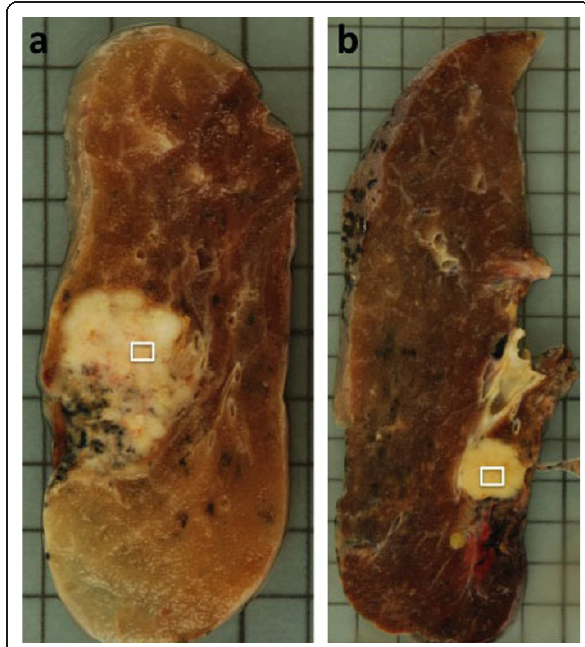
Figure 2 Macroscopic findings . Macroscopic examination of excised specimens showed the tumor measuring 36 × 25 × 30 mm in size, white in color on cut surface in the case 1 (a), and the tumor measuring 33 × 20 × 40 mm in size, grayish-white in color on cut surface containing areas of hemorrhage in the case 2 (b). White squares in Figure 2a and 2b correspond to photomicrographs of Figure 3a and 3b,